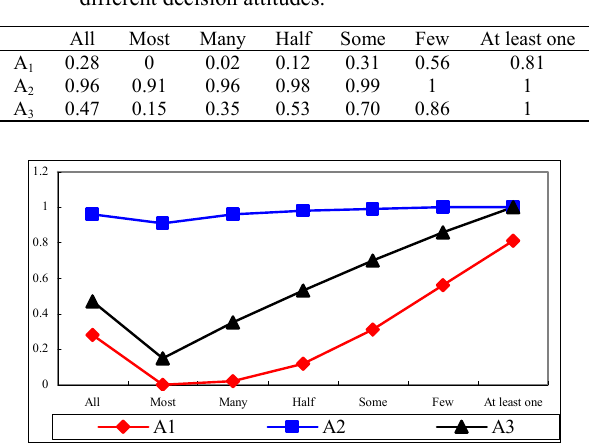
Fig. 4. Comparison of overall relative closenesses under different decision